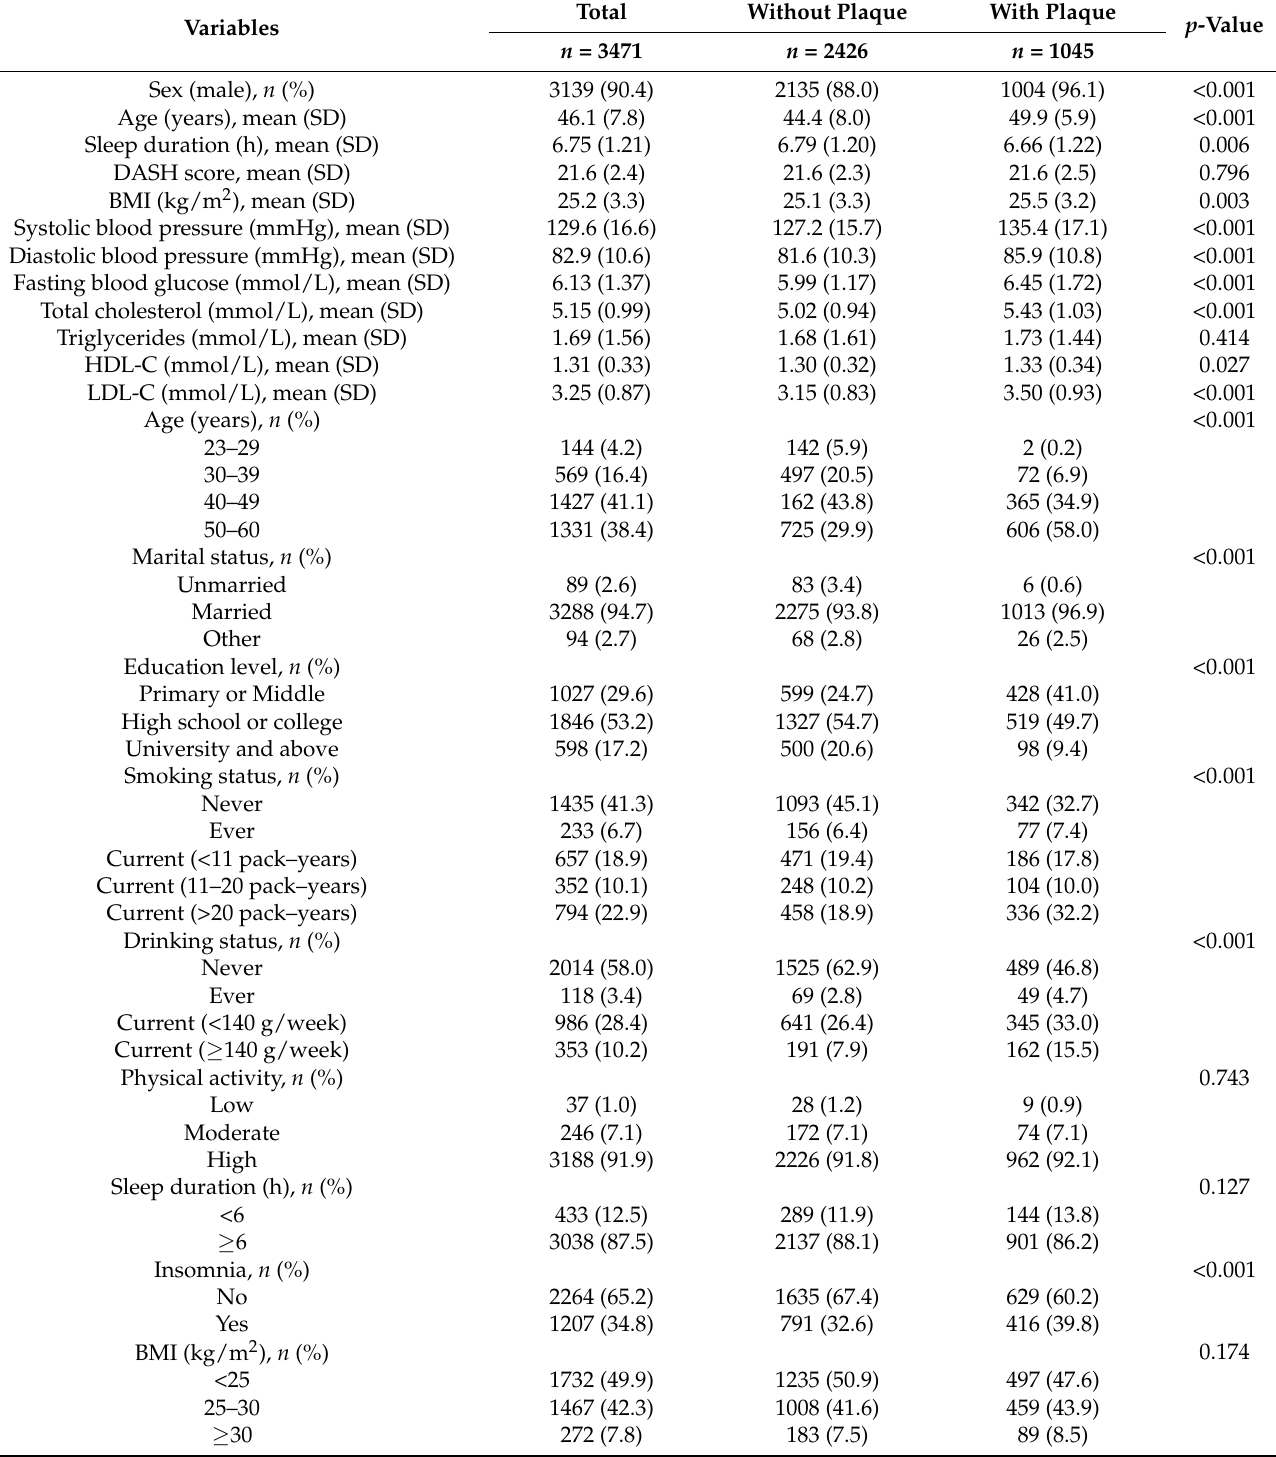
Table 1. Basic characteristics of participants according to carotid